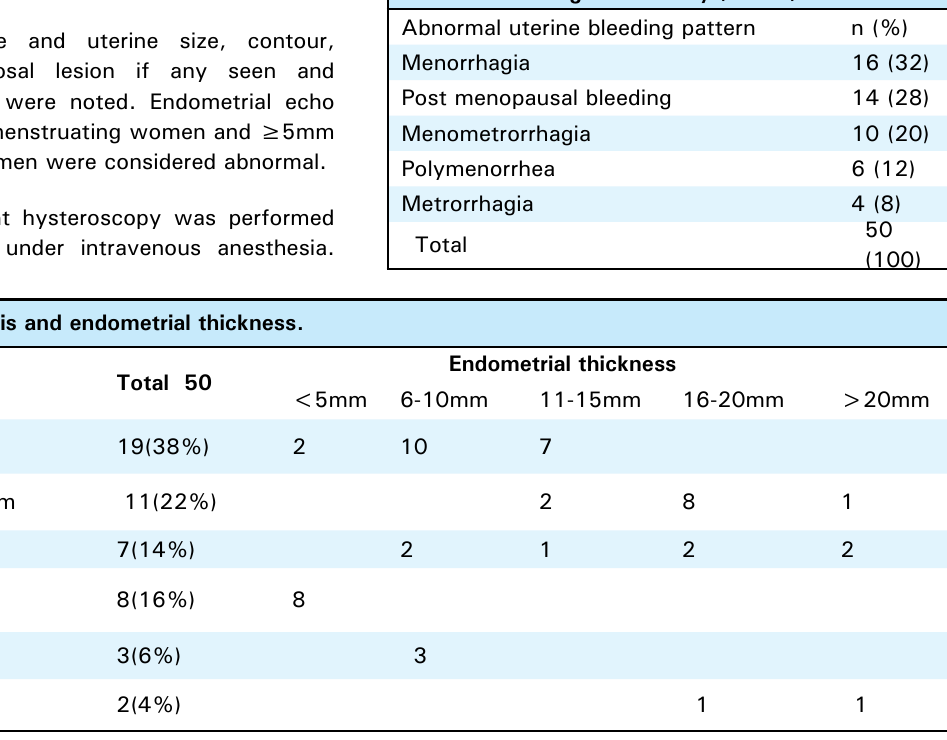
table 1. bleeding abnormality (n=50).